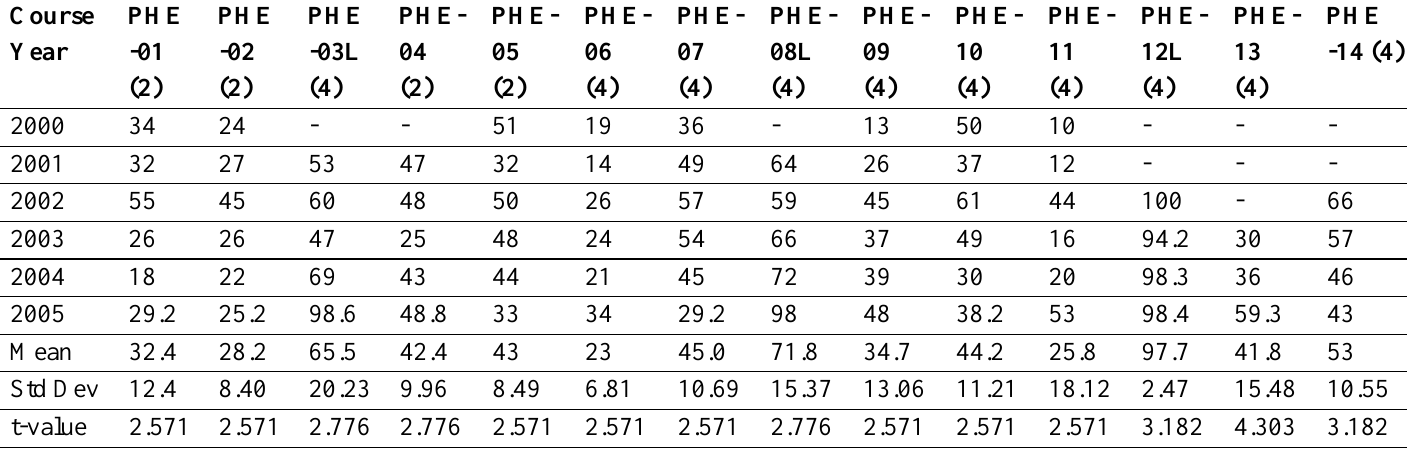
Year-Wise Pass Percentage in Physics Electives in the Period